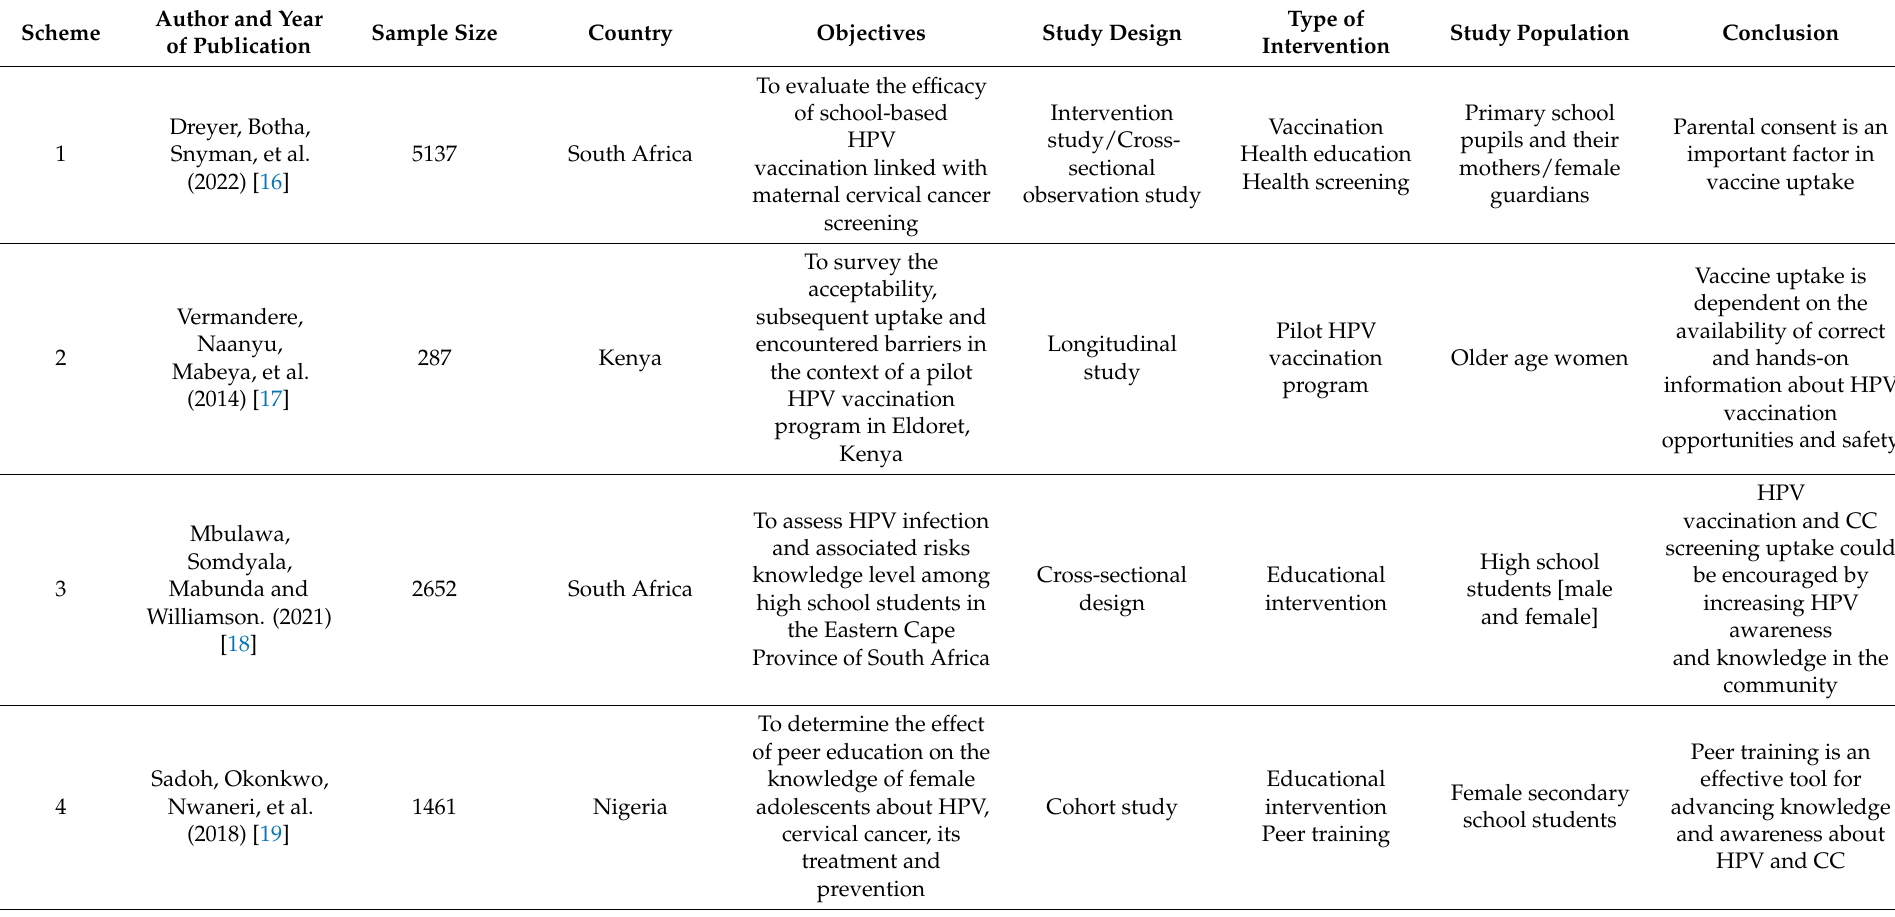
Table 1. Synopsis of the Reviewed